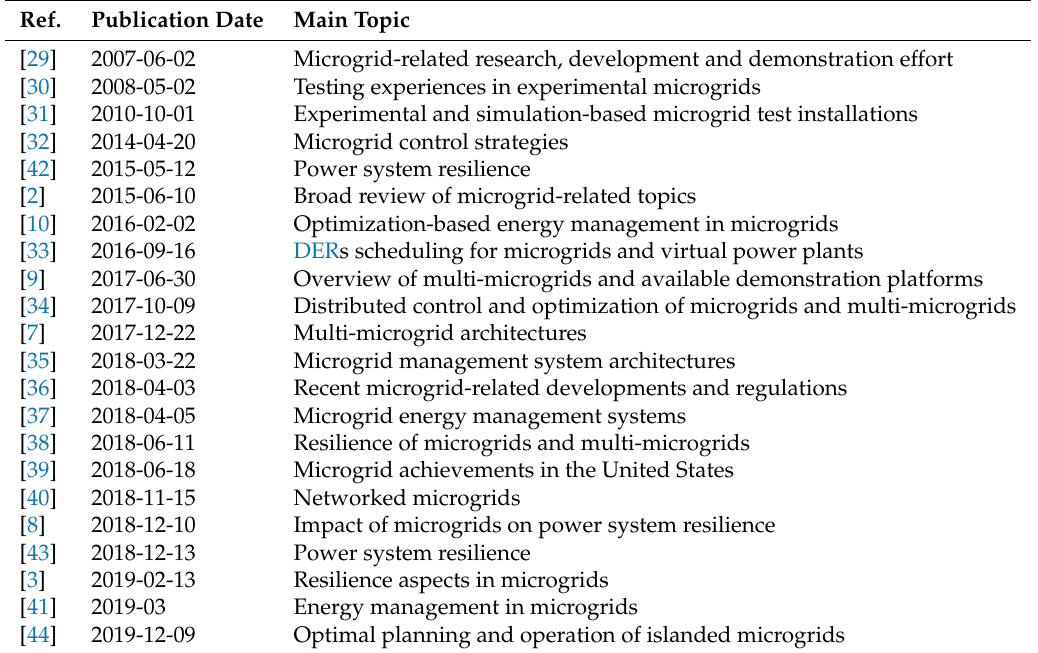
Table 1. Overview of related